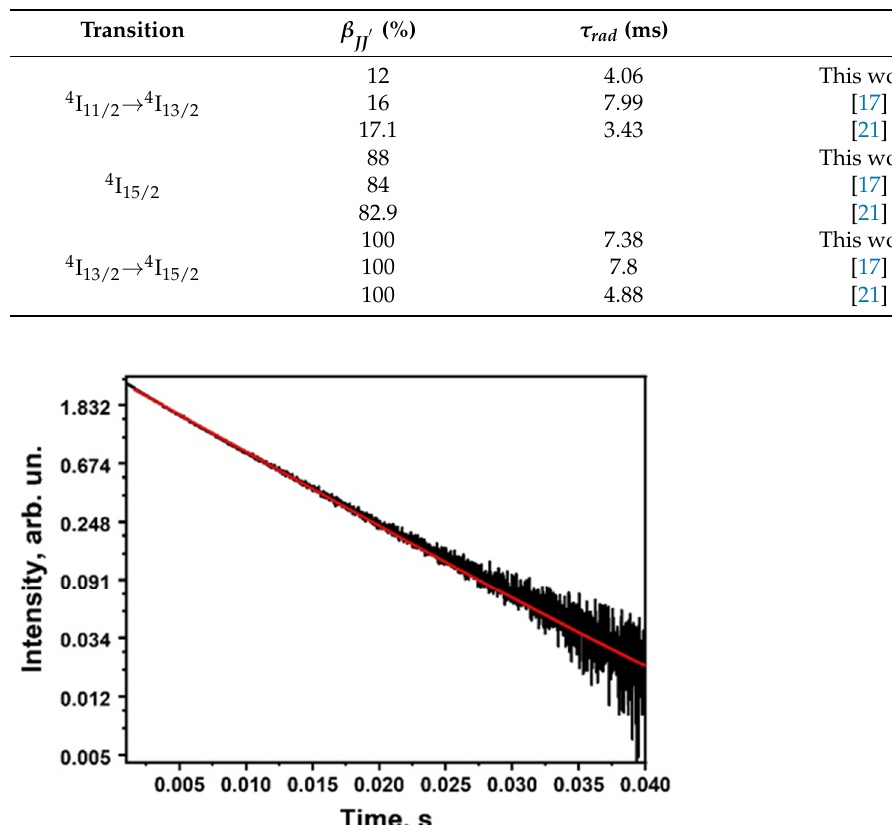
Table 4. Calculated β JJ (cid:48) , and τ rad .